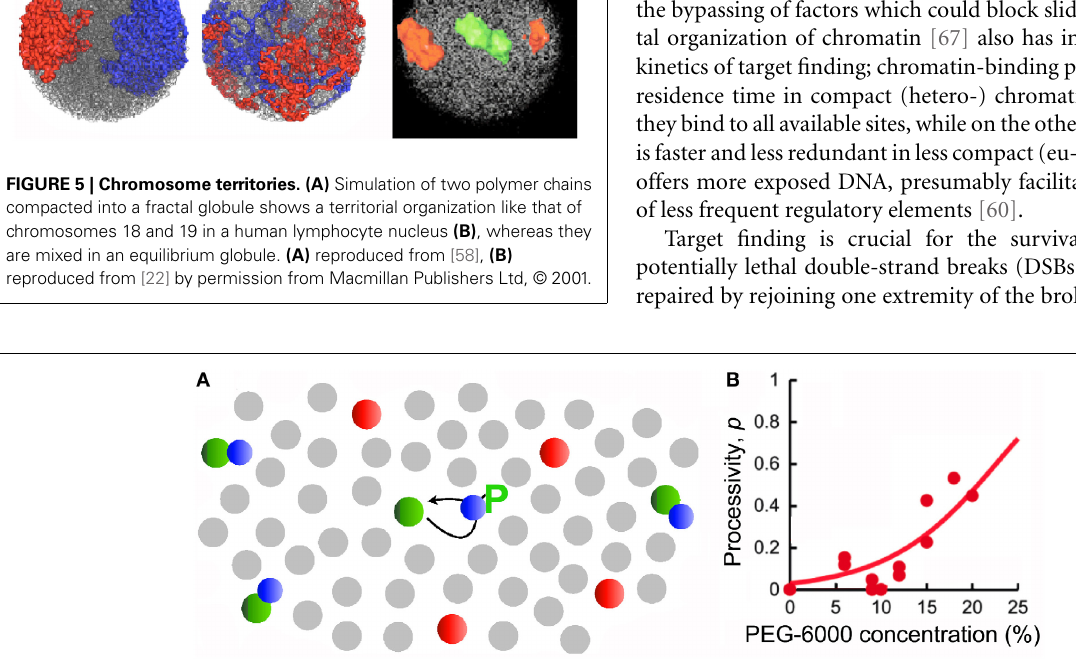
a second phosphorylation of ERK on threonine is increased (reproduced from [72] with permission from Elsevier, © 2014). (B) Experimental data using purified kinases in vitro showing how the frequency of a second phosphorylation of ERK by the same molecule of MEK (processivity) increases as a function of the concentration of the crowder PEG-6000 (reproduced from [74] by permission from Macmillan Publishers Ltd, ©